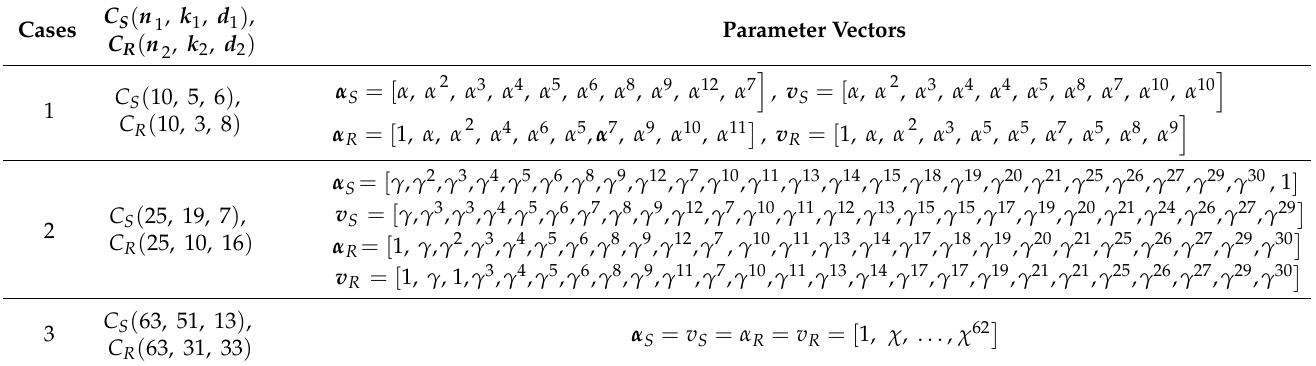
Table 8. Parameter vectors corresponding to the three